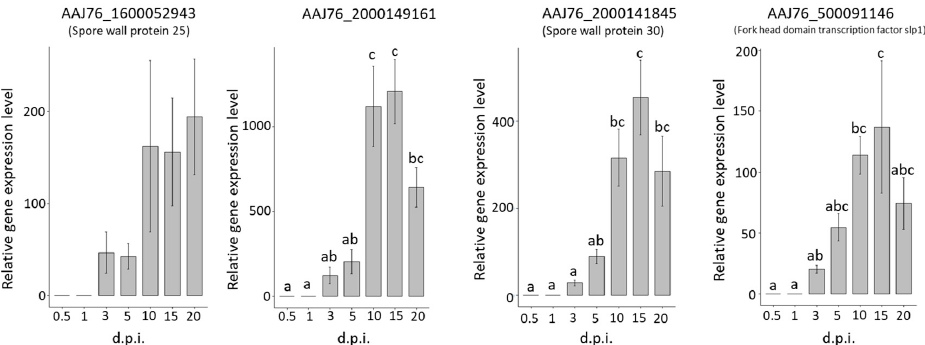
Figure 6. Validation of N. ceranae gene expression in upregulated common DEGs during N. ceranae infection. The bar plots show the relative gene expression levels of different common DEGs at different d.p.i. Different letters indicate significant differences ( p < 0.05).